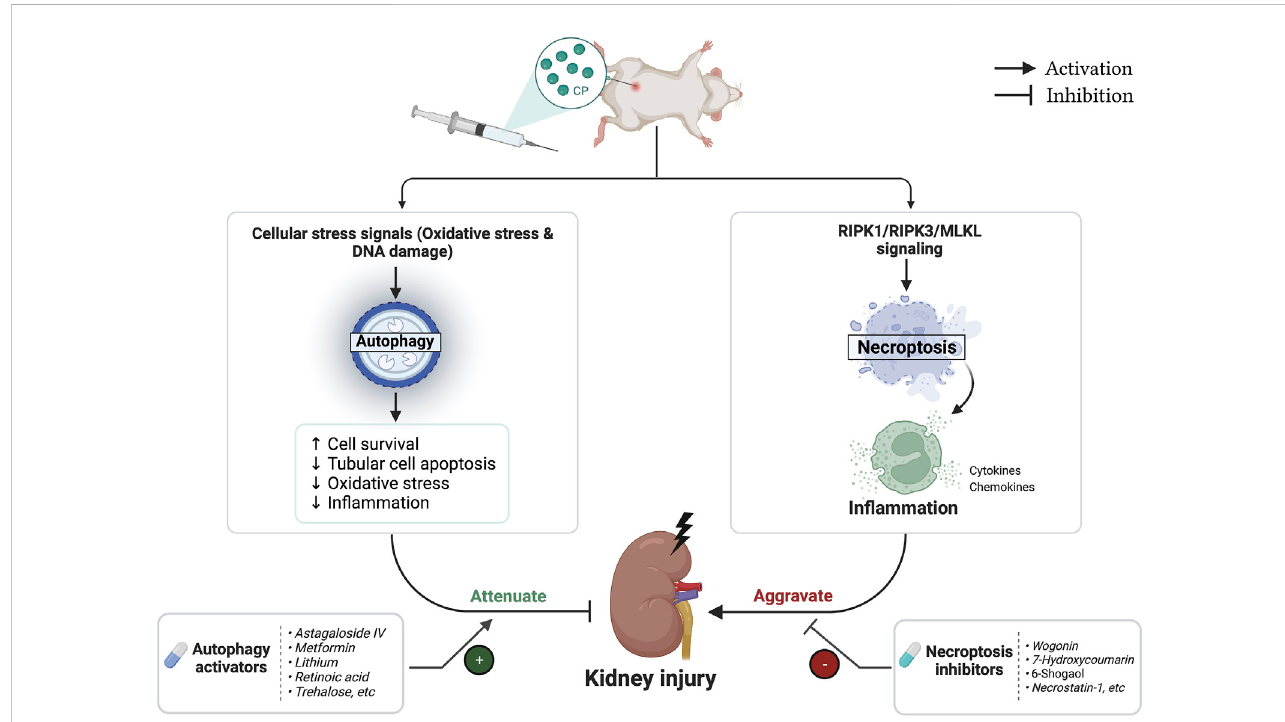
FIGURE 6 Flowchart representing the role of autophagy and necroptosis pathways during cisplatin (CP)-induced acute kidney injury (AKI).